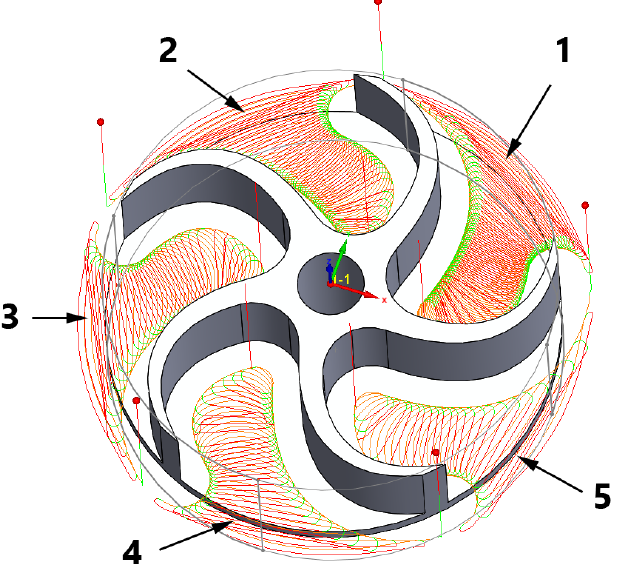
Figure 3. Toolpaths with an indication of the degree of load intensity of the